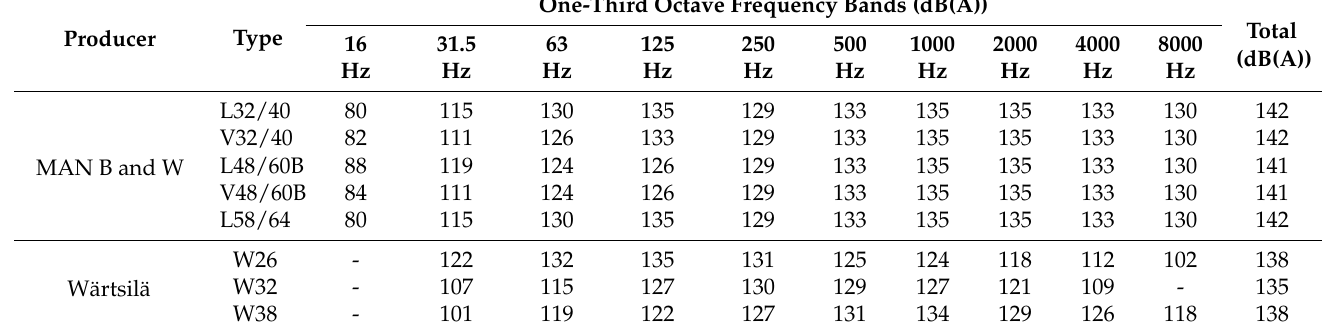
Table 4. Unattenuated one-third octave sound power level in dB(A) of the different diesel engine exhausts [25].